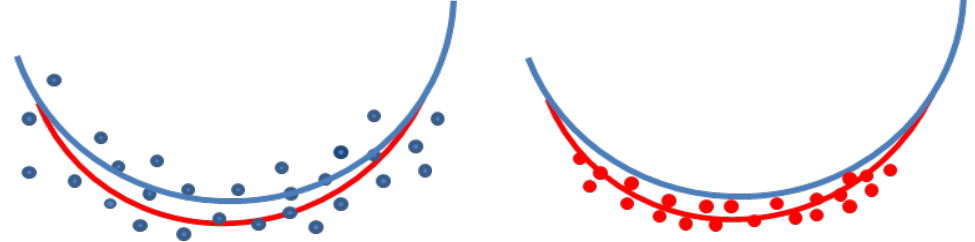
Figure 1. Diagram of comparison of orbit discrepancies detected with different types of observations ( left : pseudorange; right : pseudorange and epoch-differenced carrier-phase). The blue line represents the reference orbit, while the red line represents the true orbit in the case when there is orbit dynamic disturbance. The blue dots indicate the reference orbit based on pseudorange-only measurements, while the red dots indicate the pseudorange and epoch-differenced carrier-phase-based orbits. It can be